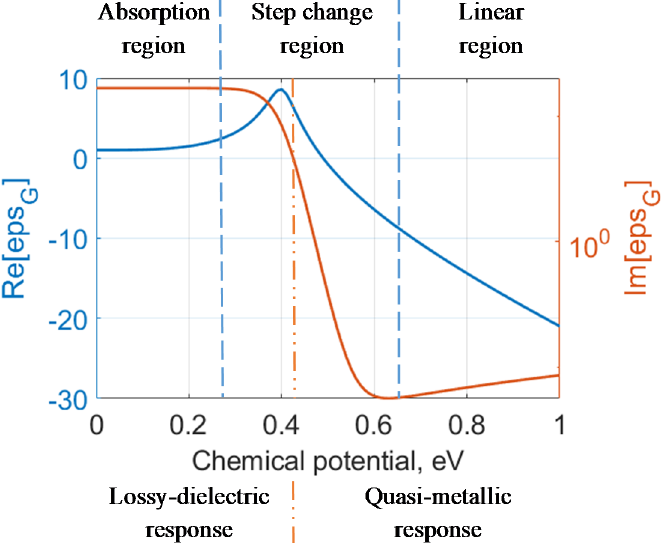
Figure 1. Zoning of the Kubo model in the | μ c | range from 0 to 1 eV using the example of the results obtained from Equation (1) from Reference [5].